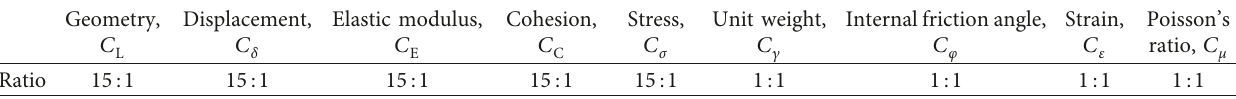
Figure 2: Unloading-loading modes associated with the adjacent high-rise buildings construction process. (a) Over unloading-loading mode. (b) Shallow-side unloading-loading mode. (c) Middle-side unloading-loading mode. (d) Deep-side unloading-loading mode. Table 2: Similarity ratio of physical quantities of similar materials.